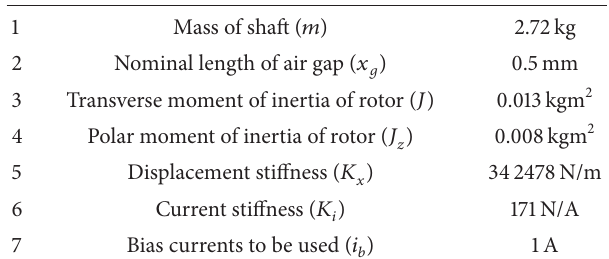
Table 1: Parameters of an AMB